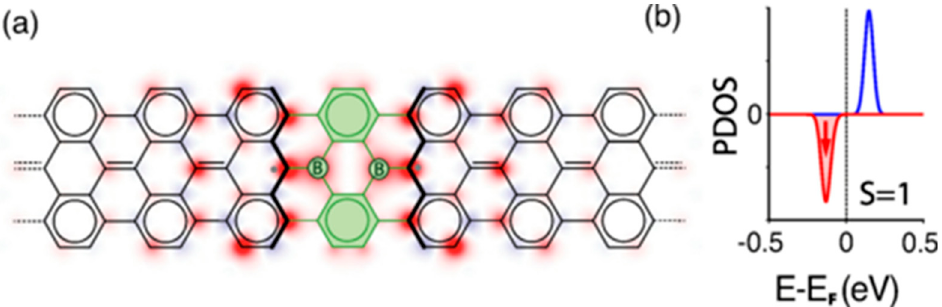
Figure 4. ( a ) Structure of the 2B-7AGNR shown over a color map representing the spin polarization density map, computed using density functional theory simulations ([16]) (green represents the